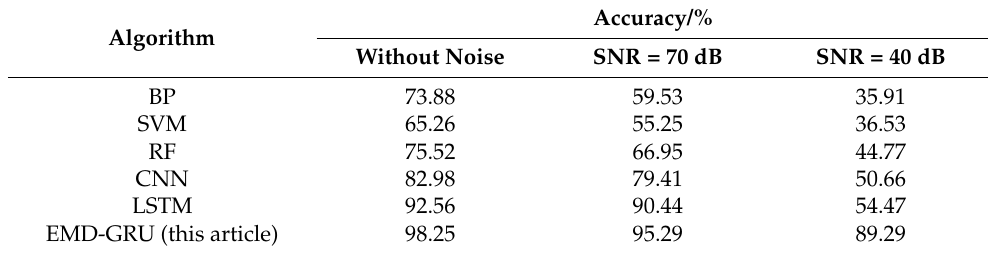
Table 9. The simulation results of different environment